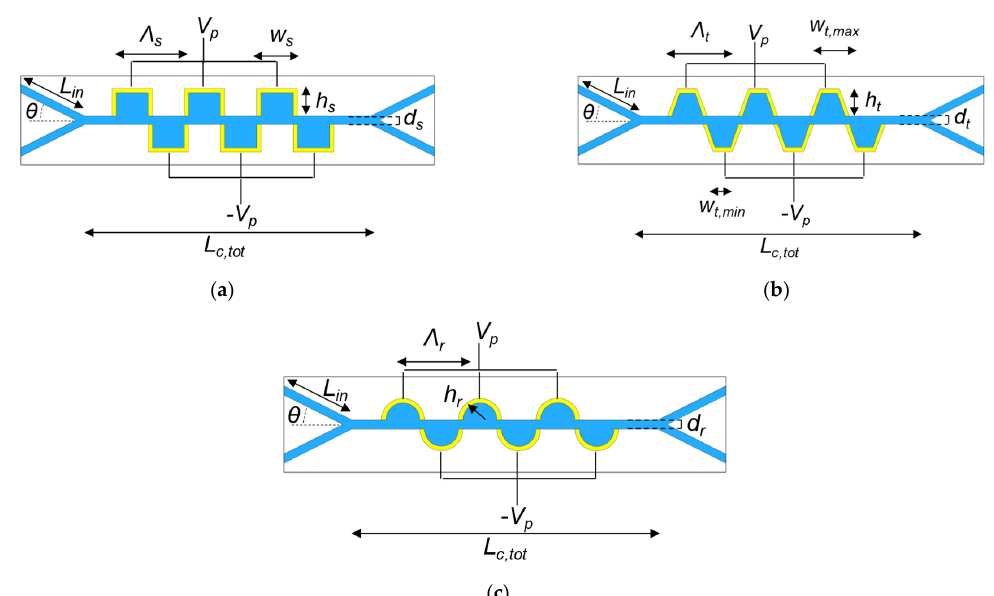
Figure 4. Microfluidic channel (blue) with ( a ) squared, ( b ) trapezoidal, and ( c ) rounded electrodes (yellow) shaping.